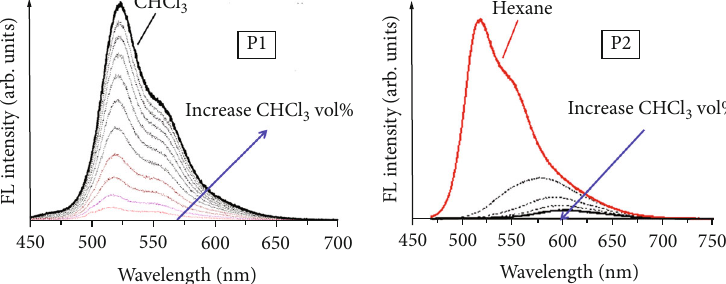
Figure 10: Absorbance-corrected fl uorescence emission (excited at the corresponding absorption maximum) spectra of P1 and P2 as dilute solutions in hexane, CHCl , or mixed hexane/CHCl solvent. Note that P2 has poor solubility in hexane, and the upper, clear portion of a 3 3 saturated P2 solution in hexane was collected and used as the stock solution. See Figure S5 for more detailed studies on P2